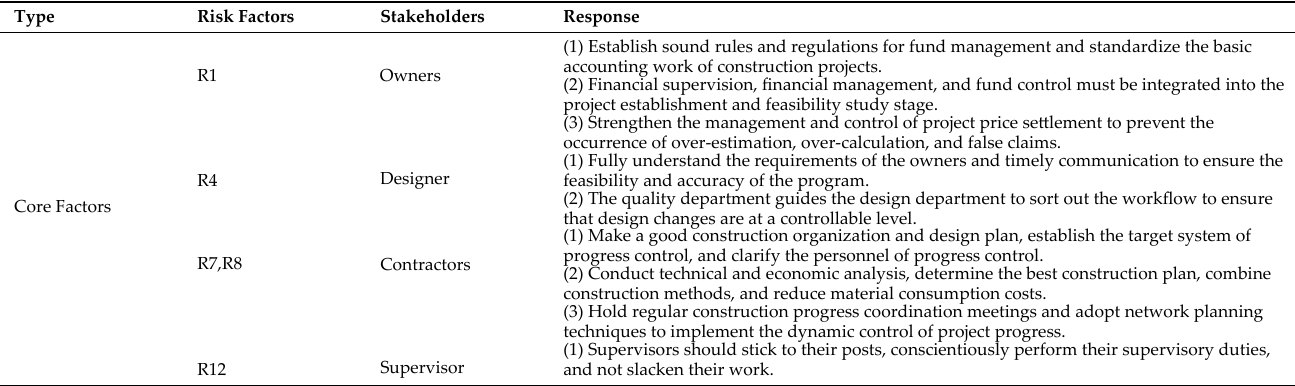
Table 7. Risk response